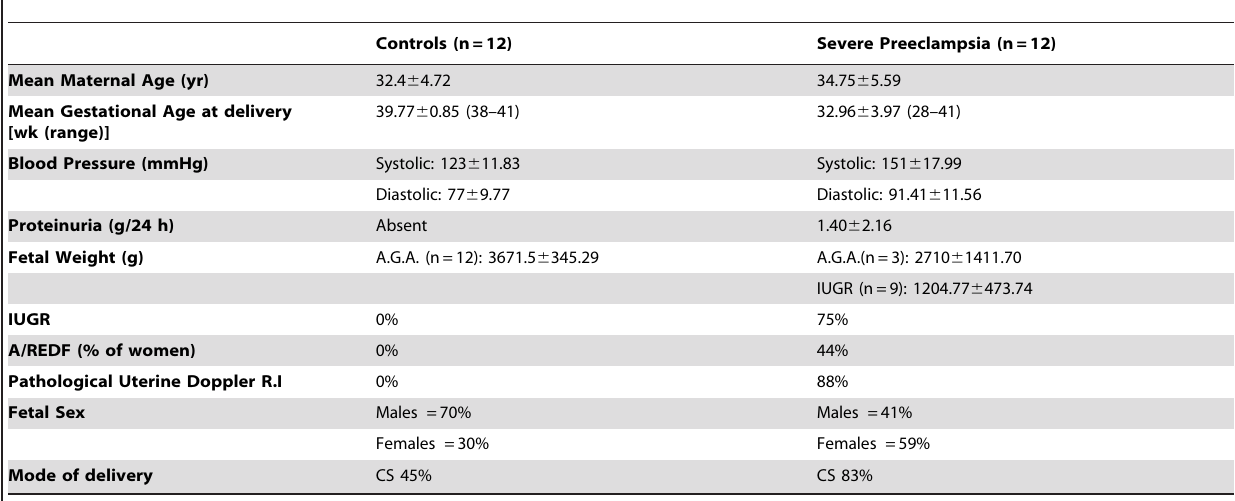
Table 1. Clinical Features of the Study